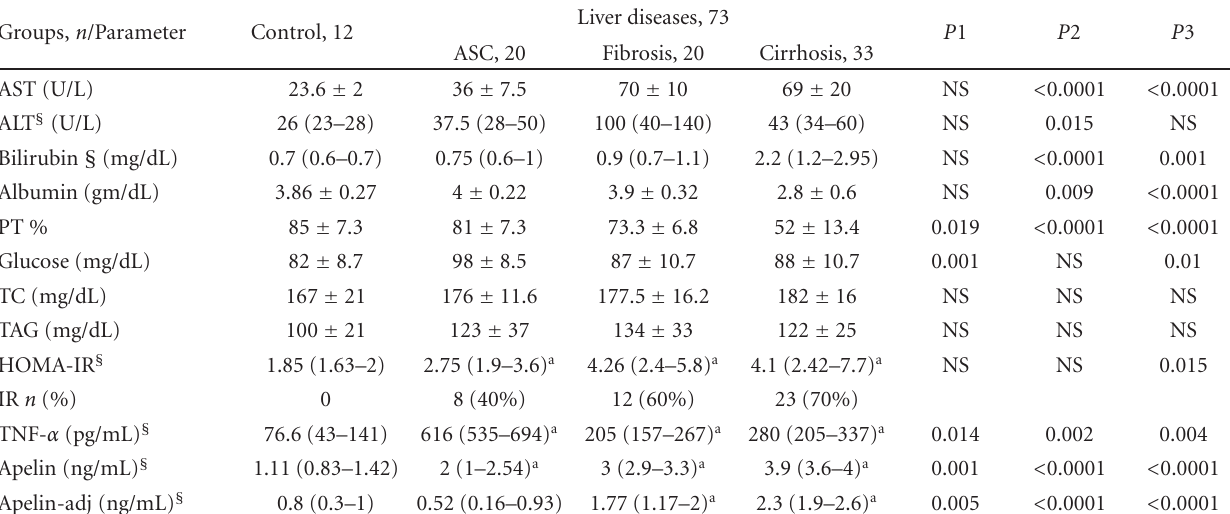
Table 2: Serum concentrations of the studied parameters in the di ff erent studied